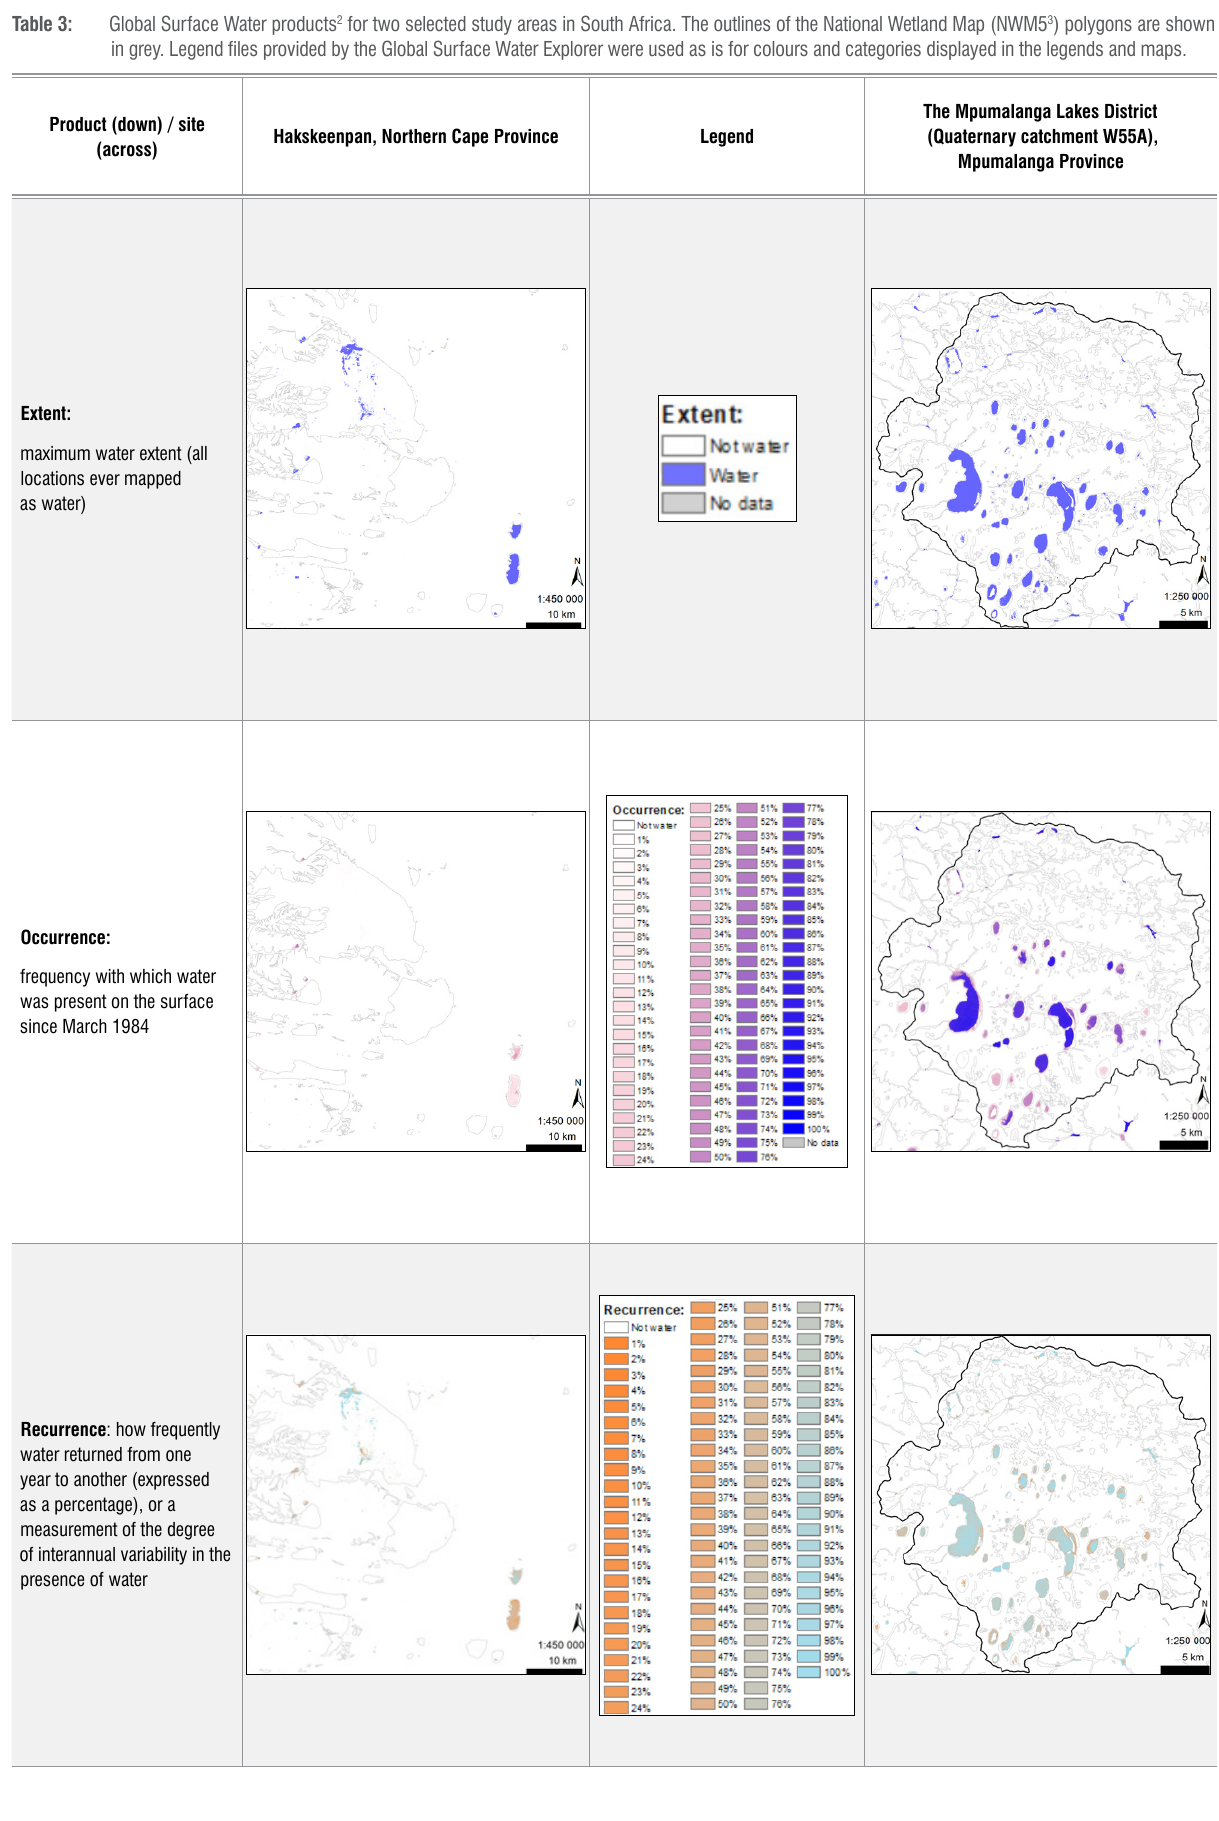
Table 3: Global Surface Water products 2 for two selected study areas in South Africa. The outlines of the National Wetland Map (NWM5 3 ) polygons are shown in grey. Legend files provided by the Global Surface Water Explorer were used as is for colours and categories displayed in the legends and maps.